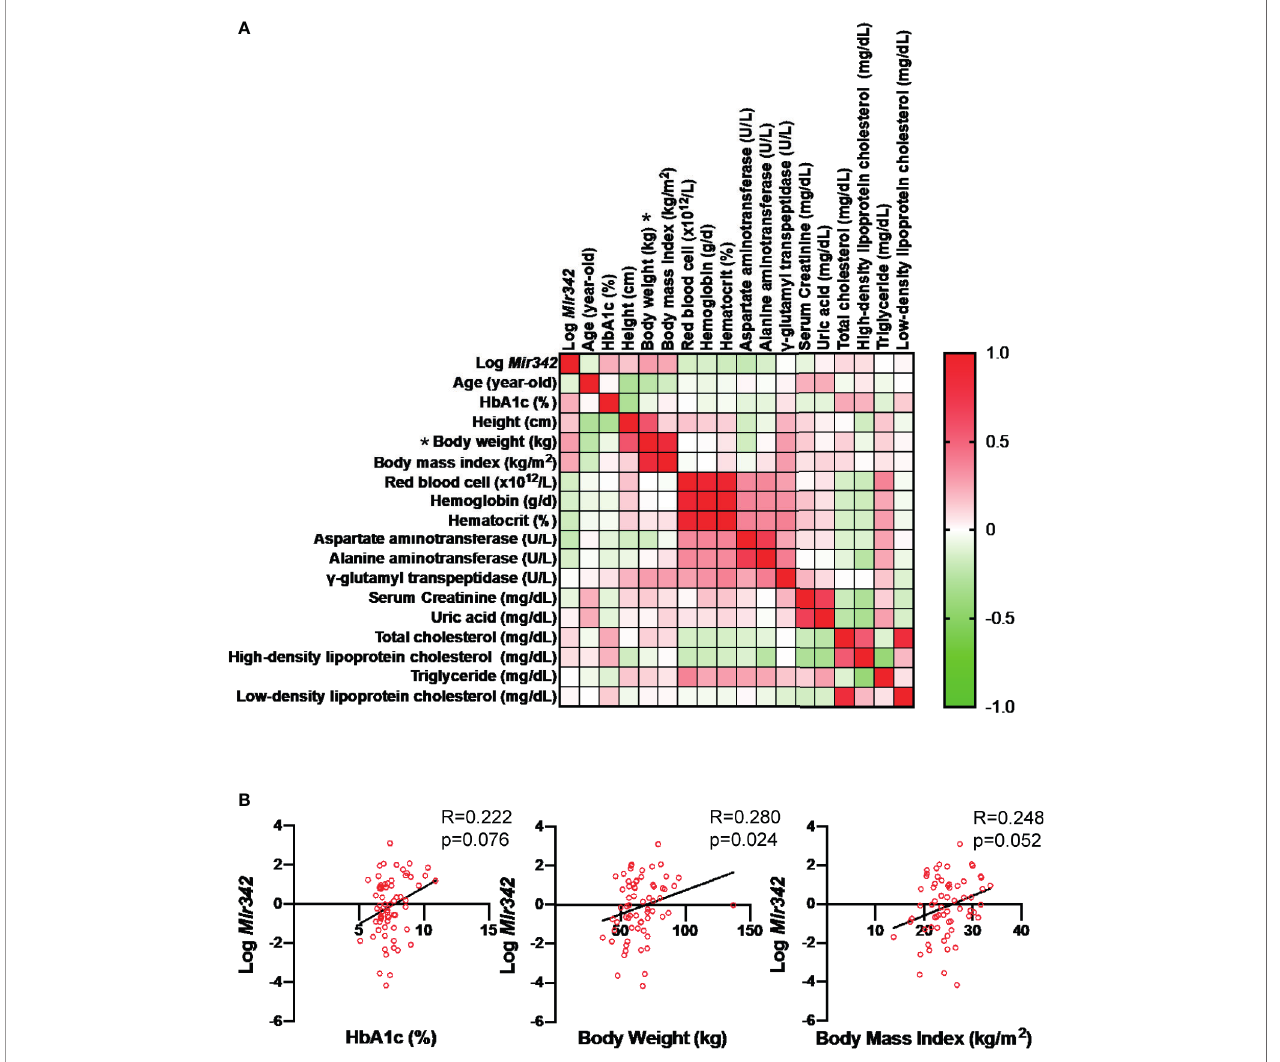
FIGURE 2 | Correlation of serum mmu-mir-342-3p levels ( Log Mir342 ) with various clinical parameters in the patients with type 2 diabetes (n=65). (A) In correlation matrix, Spearman ’ s rank correlation coef fi cient is shown. *P < 0.05. (B) The correlations between Log miR-342-3p (Log Mir342 ) with HbA1c (R=0.222, p=0.076), body weight (R=0.280, p=0.024) and body mass index (R=0.248,